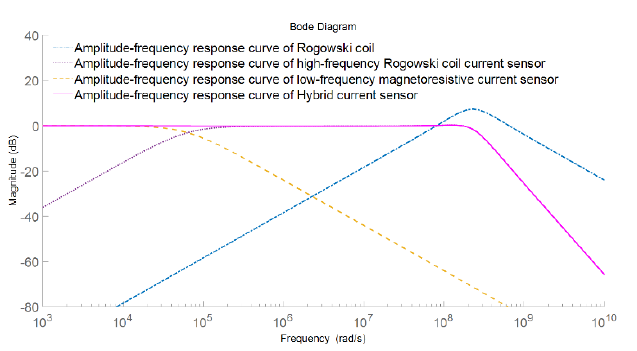
Figure 8. Amplitude-frequency response of the composite current measurement scheme.